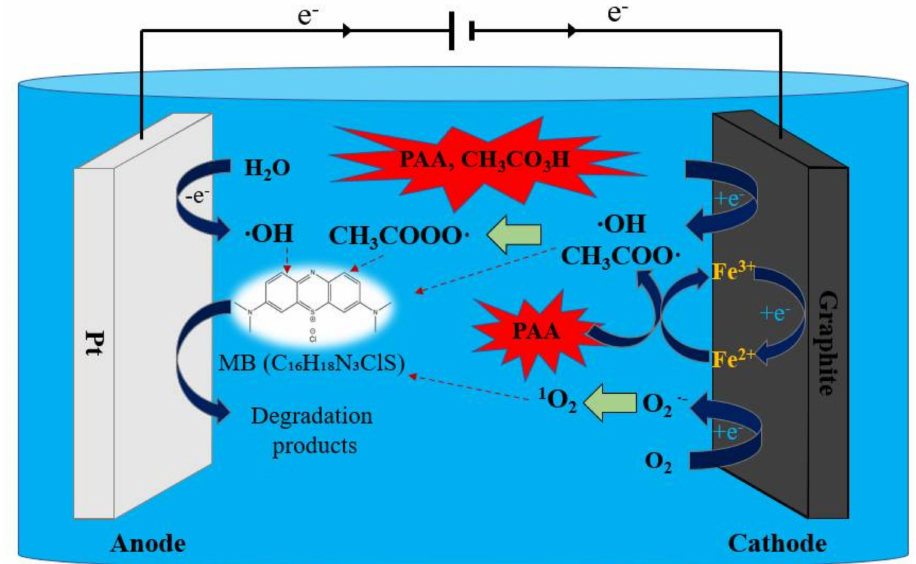
Figure 7. Possible mechanism for EC/Fe 2+ /PAA